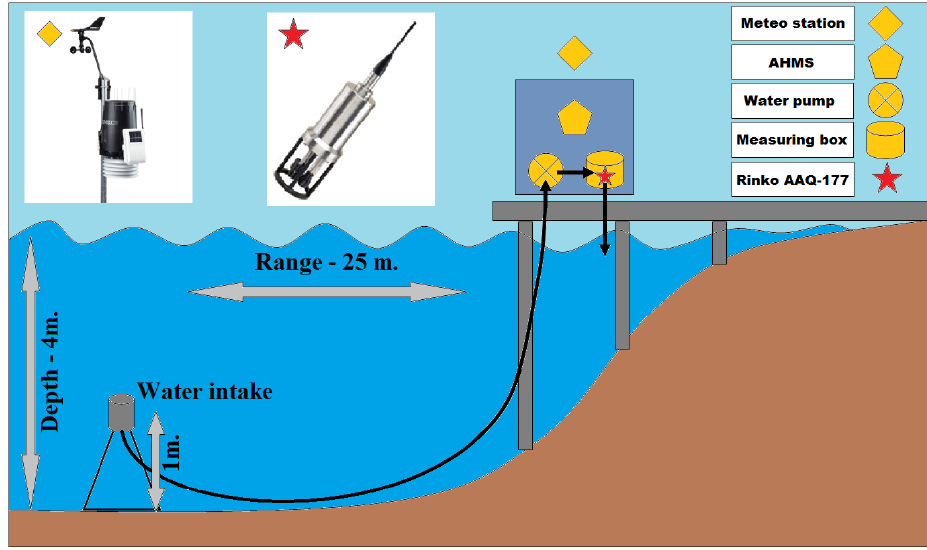
Figure 2. Configuration scheme and sensors of